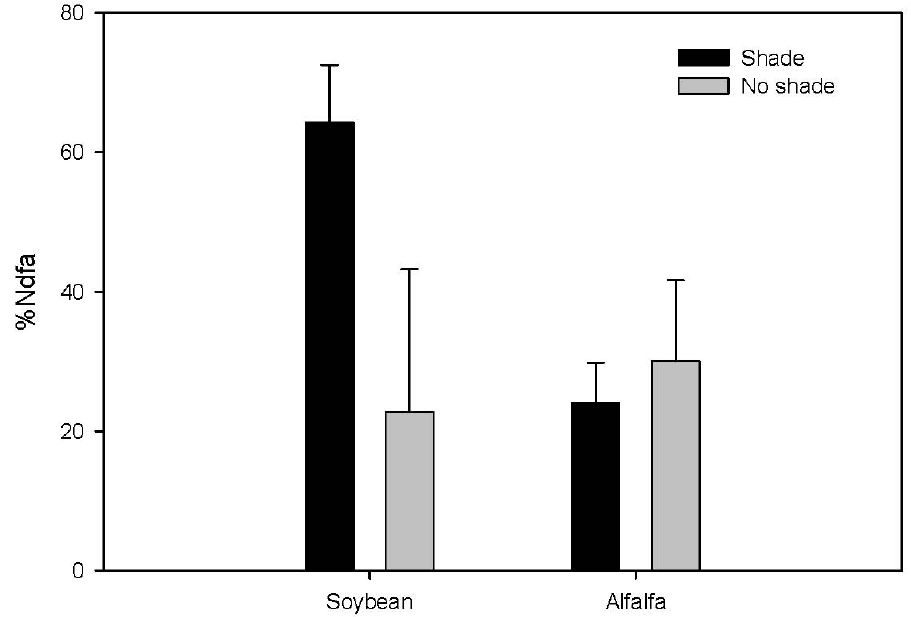
Figure 2. %N derived from atmosphere (Ndfa), determined with the natural abundance method, for soybean and alfalfa in hydroponic systems under shade and in full sun. Bars represent SE of the mean (N =